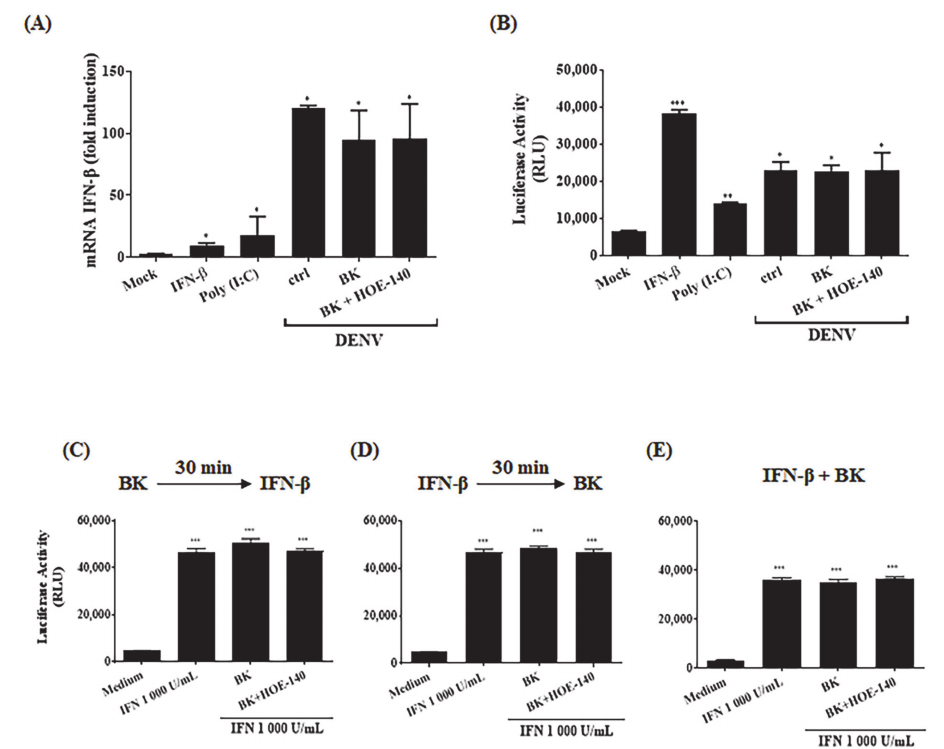
Figure 2. Addition of BK to HBMECs does not interfere with type I IFN response. ( A , B ) HBMEC pISRE luc were mock-treated or infected with DENV2. After 24h, the cells were treated with BK, in the presence or absence of HOE-140. At 48 h.p.i., the cells were harvested. As controls, the cells were treated with IFN- β or poly (I:C) for 24h. ( A ) Cell RNA was extracted and analysis of IFN- β mRNA was performed by qRT-PCR. ( B ) The cells were lysed, vortexed, centrifuged and the supernatant were mixed with substrate of luciferase enzyme to analyze the luminescence emission. The data are representative of three independent experiments and error bars indicates SD values between replicates in all experiments. ( C – E ) HBMECs were stimulated with IFN- β for 24h. BK was added, in the presence or absence of HOE-140, at different time points, as indicated: 30 min before the addition of IFN- β ( C ), or 30 min after the addition of IFN- β ( D ), or simultaneously to the addition of IFN- β ( E ). The luciferase activity was measured as in ( B ). The data are representative of three independent experiments and error bars indicates SD values between replicates in all experiments. * indicates p ≤ 0.05; ** p ≤ 0.01; *** p ≤